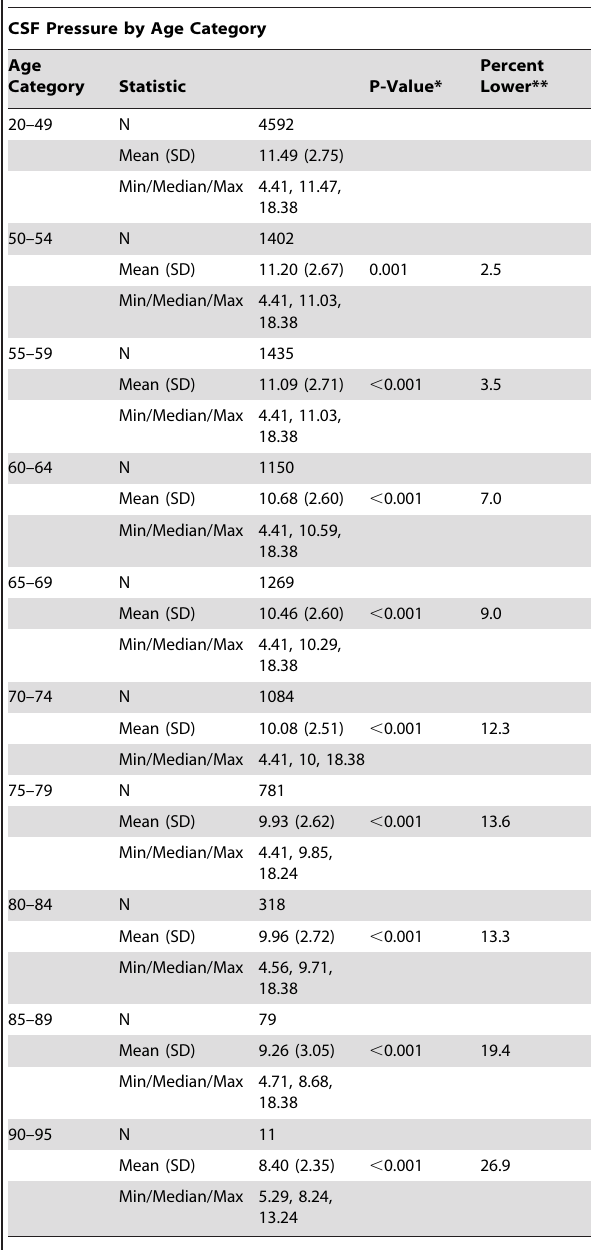
Table 4. Mean cerebrospinal fluid pressure (mm Hg) by age categories.